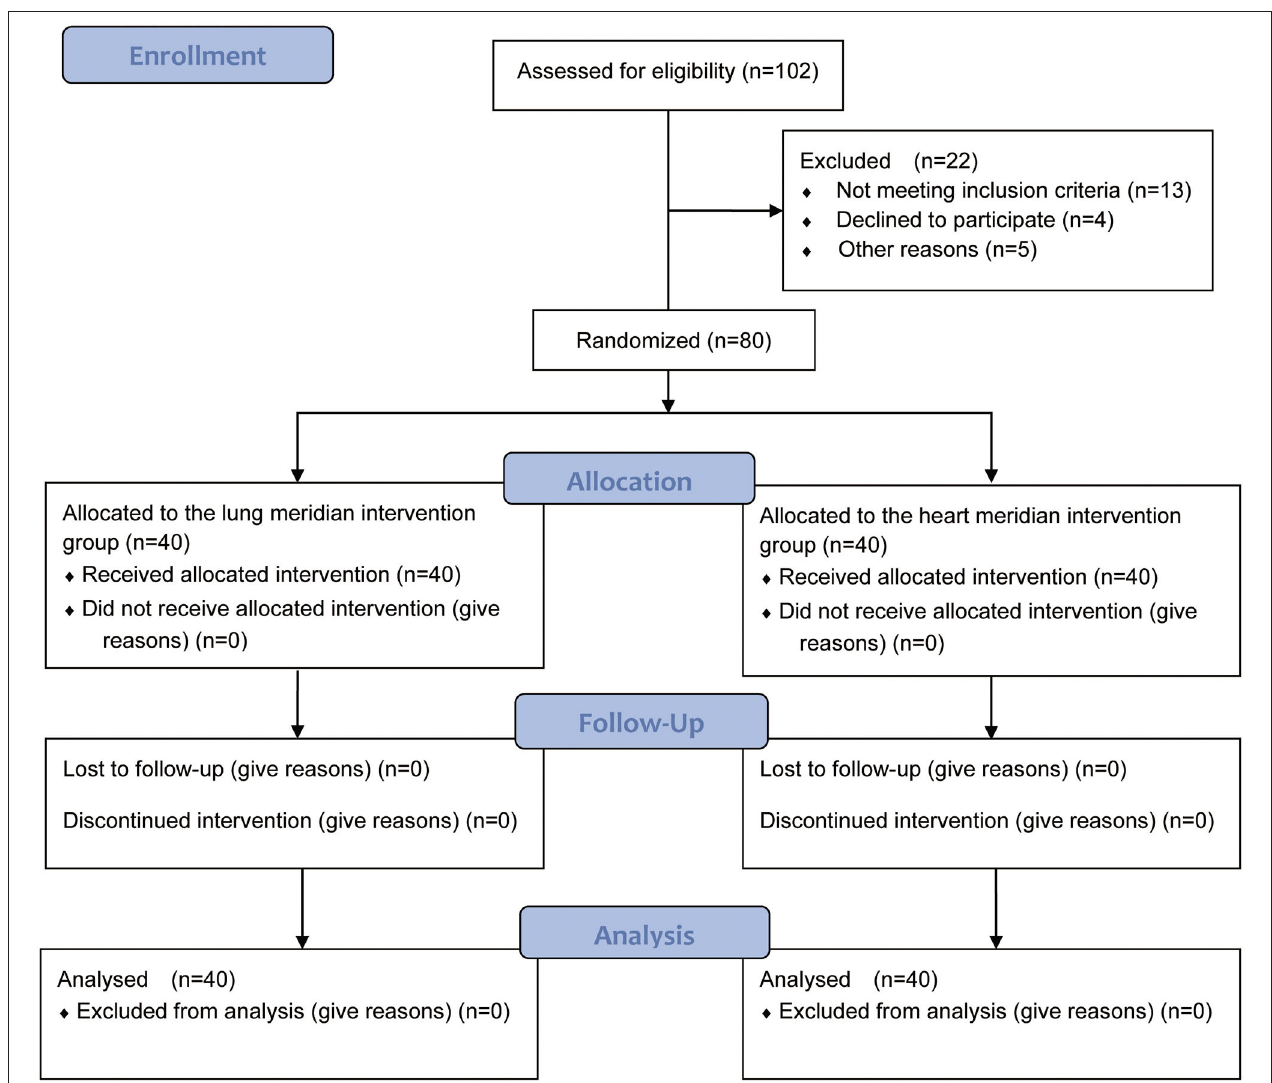
FIGURE 1 | Flow diagram of the participants through the study [With reference to the CONSORT 2010 Flow Diagram, Schulz et al., BMJ, 2010, 340: p. c332;